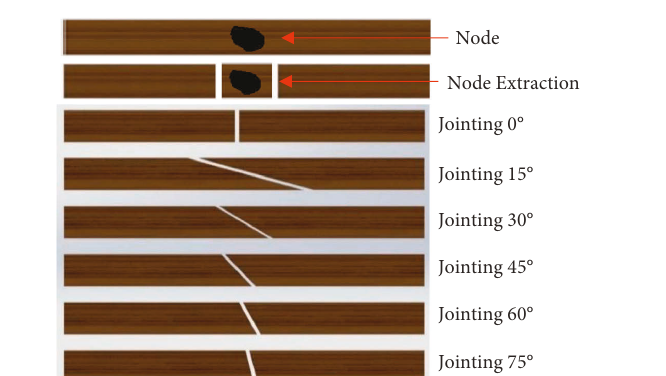
Figure 4: Various configurations of the slats butted by beveling manufactured by removing the